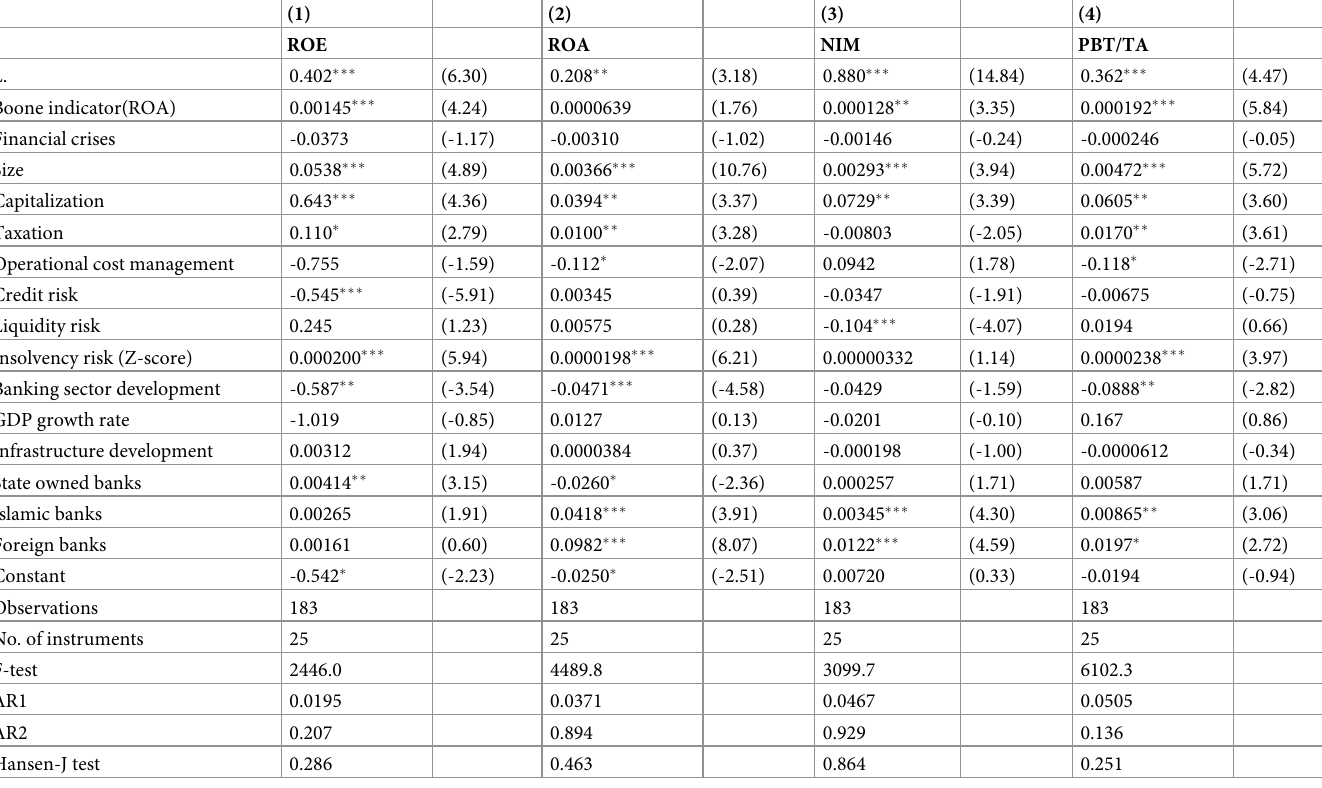
Table 8. When the competition is measured through the Boone